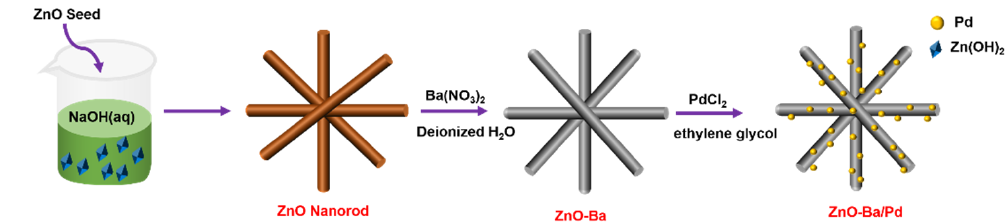
Figure 1. Schematic illustration of the fabrication of ZnO-Ba/Pd sensitive material.